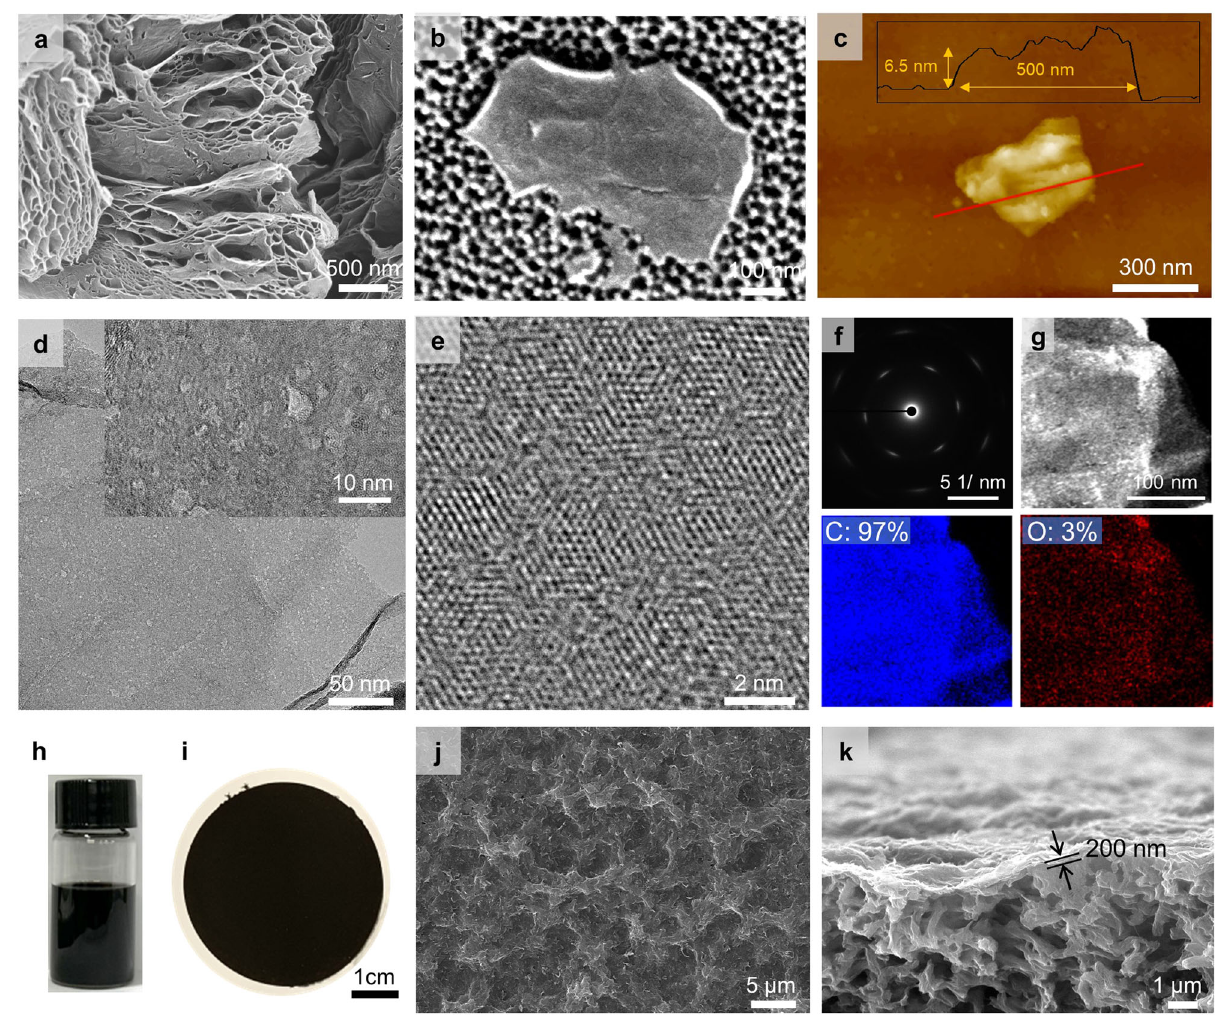
Fig. 2 | Structure of sp2-enriched nanoporous graphene and its membrane. a , b SEM images of MNG particle and exfoliated nanosheet. c AFM image of MNG nanosheet and its height pro fi le. d , e HR-TEM images of MNG. f Corresponding selected area electron diffraction (SAED) pattern of MNG obtained from d . g TEM